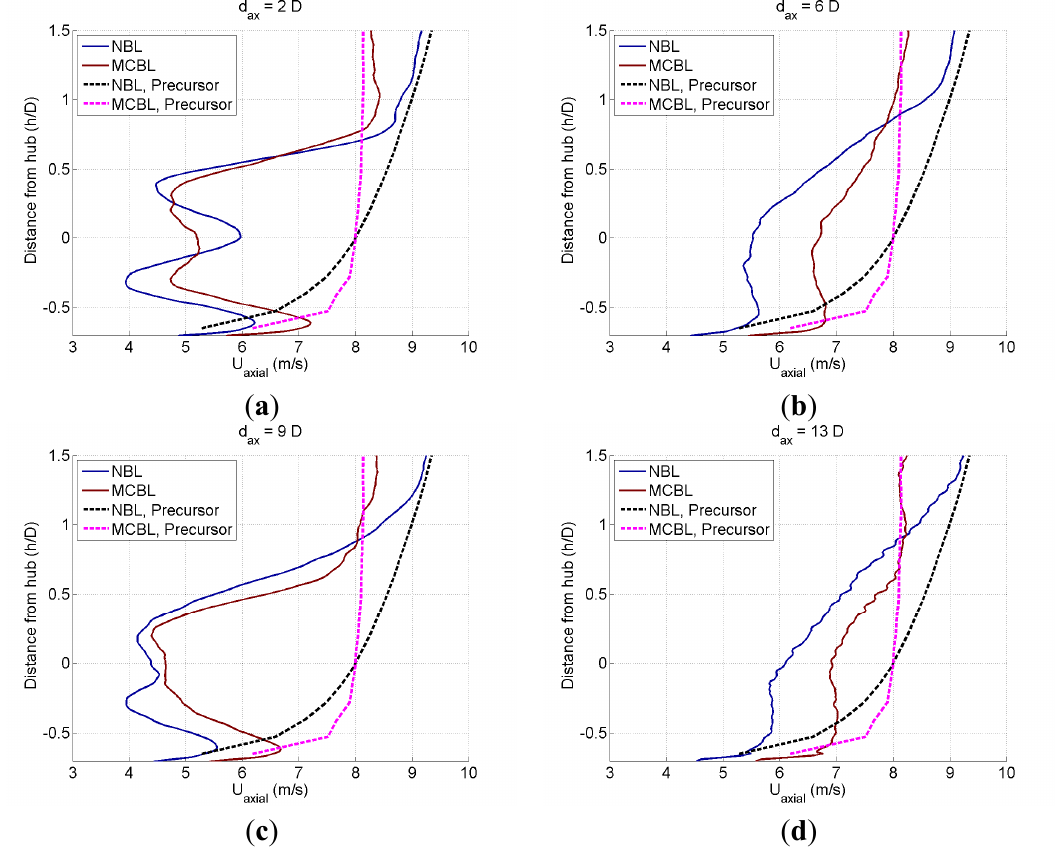
Figure 10. Mean streamwise velocity distributions in the vertical direction. (Turbine-Turbine Interaction Problem, V Wind = 8 m/s). ( a ) 2D downstream of Turbine 1; ( b ) 6D downstream of Turbine 1; ( c ) 2D downstream of Turbine 2; ( d ) 6D downstream of Turbine